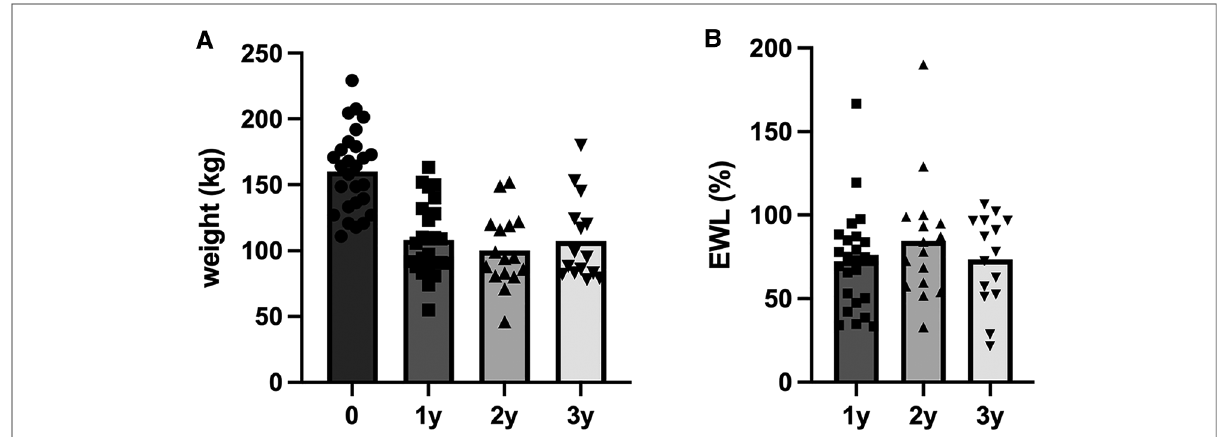
FIGURE 1 Development of weight of patients undergoing bariatric surgery suffering from liver cirrhosis ( n =27). Weight (kg) at time of surgery (0), 1 year (1y), 2 years (2y), and 3 years (3y) after surgery ( A ). Excess weight loss [EWL (%)] after 1, 2, and 3 years ( B